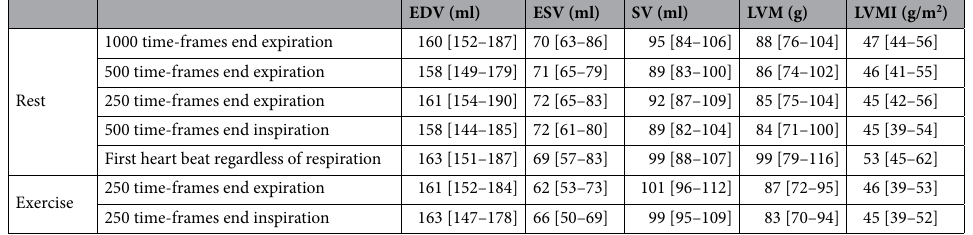
Table 2. Median values of LV volume and mass measurements from RT short-axis image stacks originating from 1000, 500, and 250 time-frames at end expiration, end inspiration, regardless of respiratory state, at rest and during exercise in eight healthy volunteers. Values are presented as median [IQR]. RT real-time, EDV end diastolic volume, ESV end systolic volume, SV stroke volume, LVM left ventricular mass, LVMI left ventricular mass index, ICC intraclass correlation coefficient, CI confidence